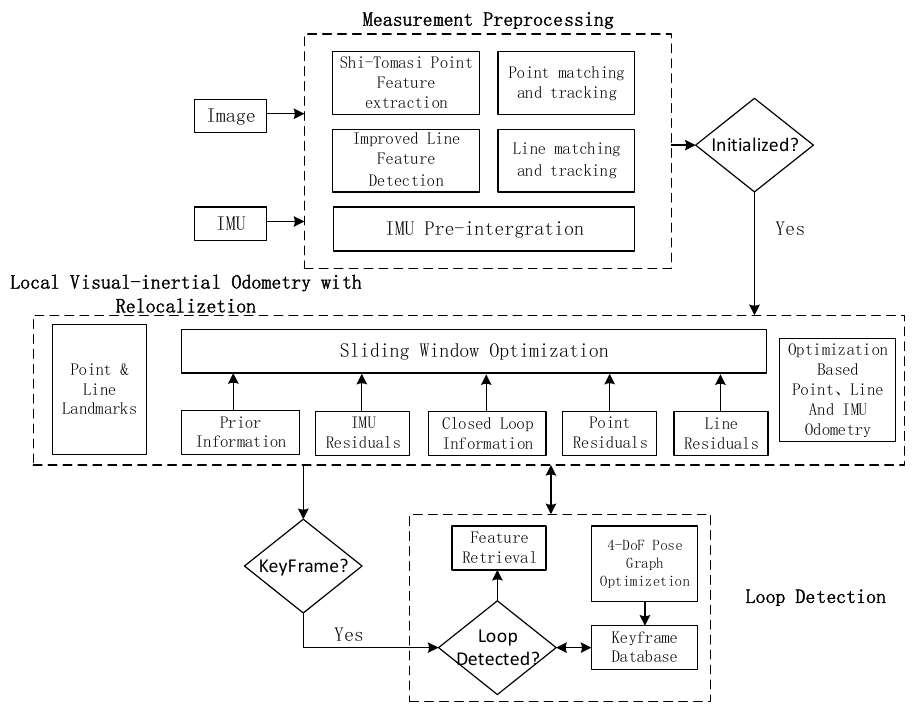
Figure 1. The system of PLI-VINS.